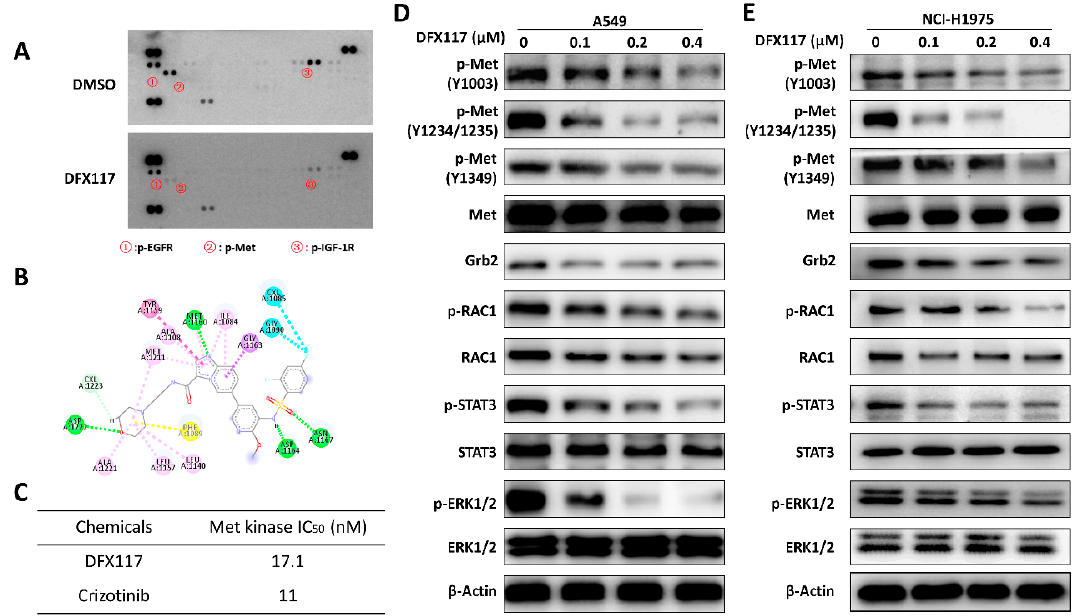
Figure 3. DFX117 inhibit Met kinase activity. ( A ) Phospho- receptor tyrosine kinase (RTK)